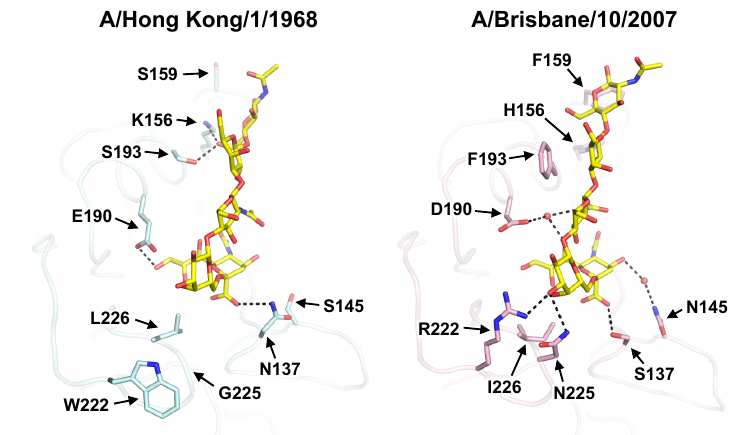
Figure 1. Natural evolution of receptor-binding mode in seasonal influenza virus. Crystal structures of human receptor analog (6 (cid:48) -SLNLN, yellow) in complex with HAs from two human H3N2 influenza strains that were isolated 40 years apart, namely A / Hong Kong / 1 / 1968 (cyan) and A / Brisbane / 10 / 2007 (pink), are shown. Representative residues in the receptor binding site (RBS) that were mutated during the course of natural evolution are shown in stick representations. Hydrogen bonds are shown as dashed lines. All structure images in this review were rendered by PyMOL